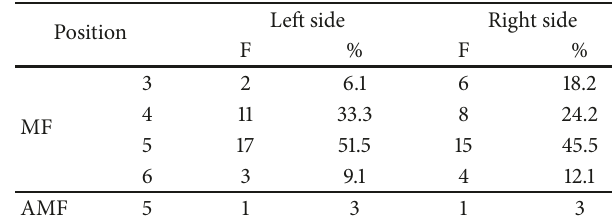
Table 3: Frequency of MF and AMF positions in relation to mandibular teeth in Zambian adult human mandibles